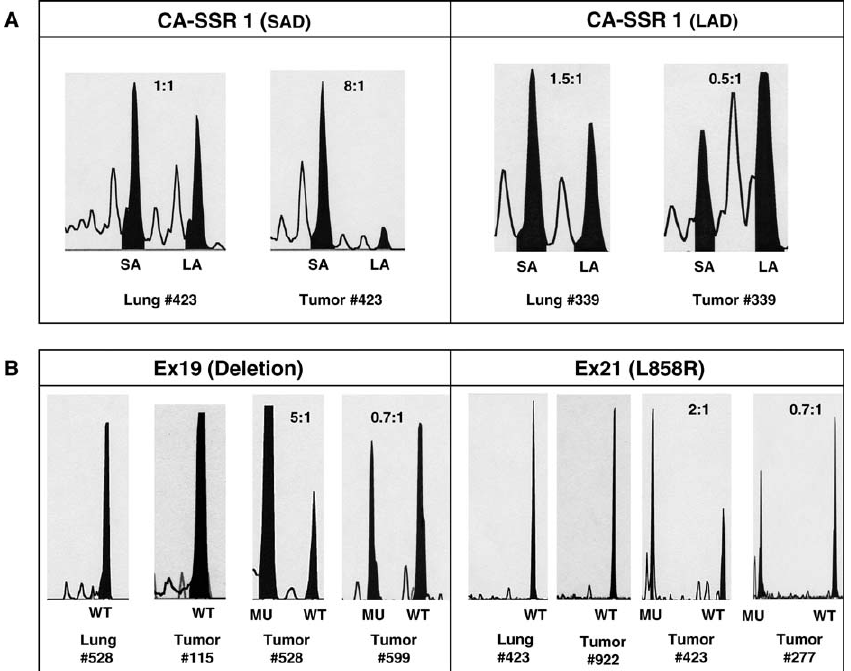
Figure 1. Determination of AI for Heterozygous for CA-SSR1 and for Tumors Having a Deletion Mutation in Exon 19 or the L858R Mutation in Exon 21 Representative wave patterns are illustrated for (A) the CA-SSR1 allele and (B) the deletion mutation in exon 19 or L858R mutation in exon 21. Both tumors and corresponding lung tissue were analyzed. Note in (A) the ratio of shorter allele to longer allele is actually 1.3:1, as illustrated for lung #423, due to artifactual preferential amplification of the short allele. Thus, an appropriate correction factor is applied.